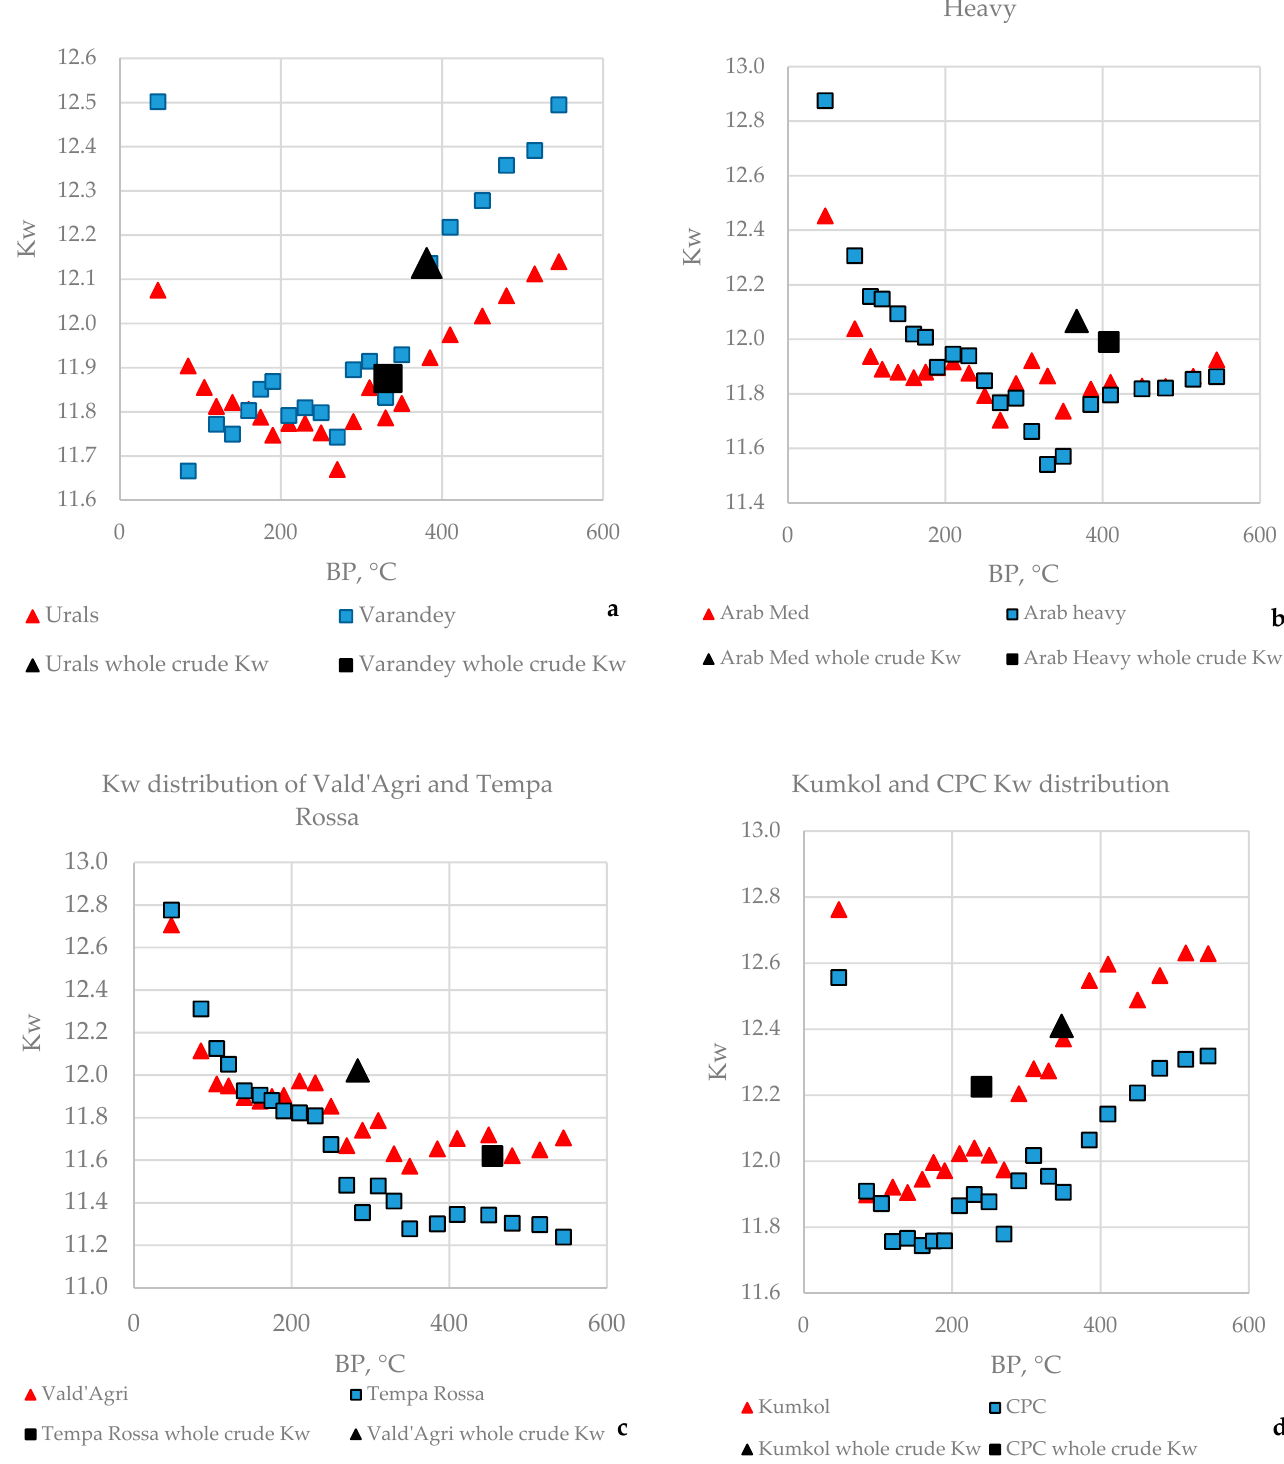
Figure 6. Kw characterization factor of narrow fraction distributions and the whole crude oil Kw characterization factor for the different crude oils studied in this work ( a – d ).